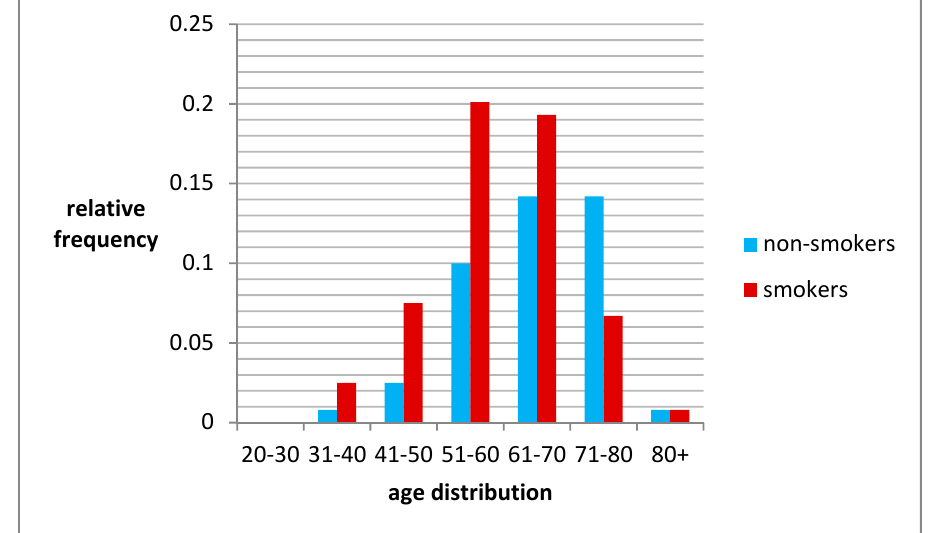
Figure 3. Occurrence of smokers / non ‐ smokers in age groups.